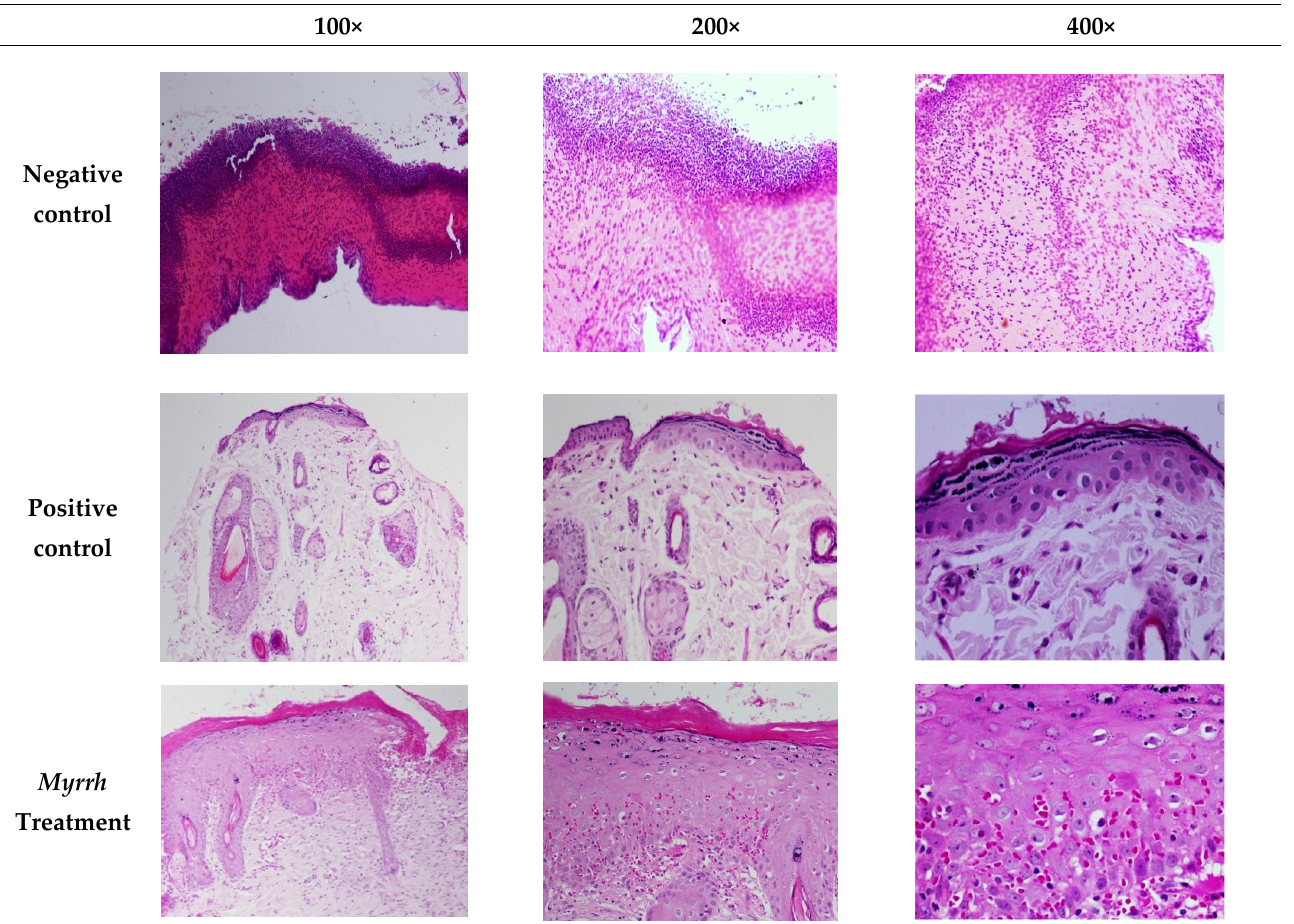
Figure 8. The histological alteration of rat wounds treated with myrrh methanolic extract, bepanthine, and the negative control. Bepanthine- and myrrh-treated wound revealed normal epidermal cells and re-epithelialization comparable to the negative control group.